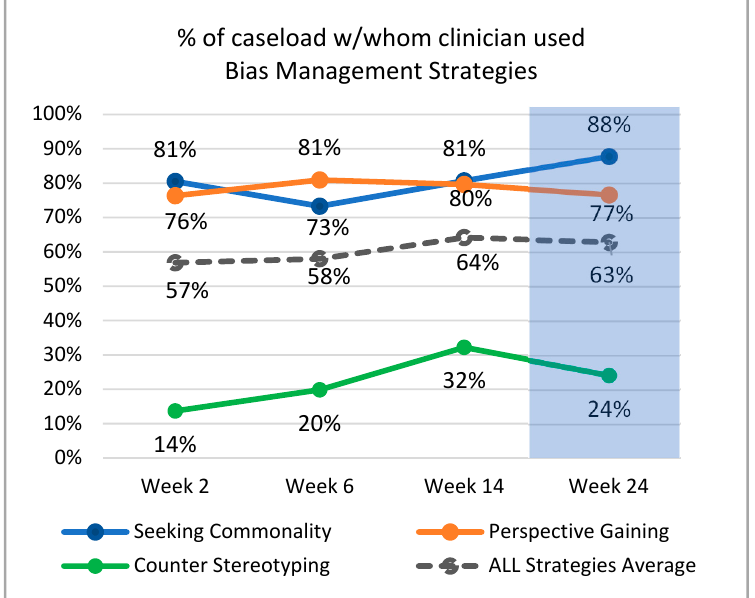
Figure 3. Average Frequency of VIBRANT Strategies Use across Clinicians’ Caseloads.